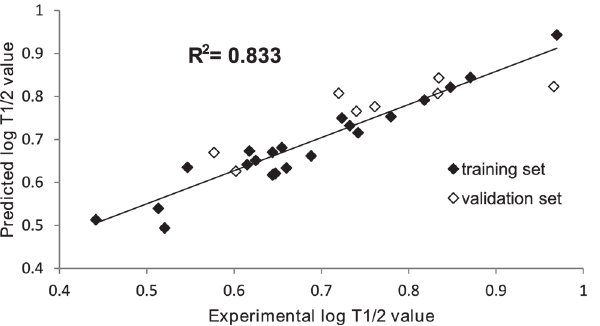
Fig 4. Correlation between the experimental log t 0.5 values and the ones predicted by Support Vector Machine learning. The correlation coefficients are R ’ = 0.939 for the training set, R ” = 0.844 for the test set and R ”’ = 0.913 for both sets. The mean squared error was MSE ’ = 0.002 for the training set, MSE ” = 0.005 for the test set and MSE ”’ = 0.003 for both